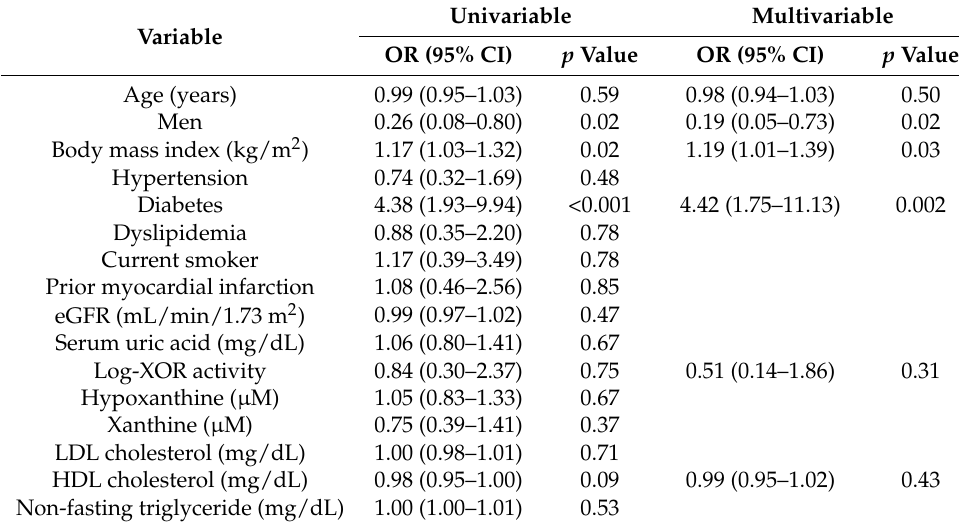
Table 2. Factors associated with an endothelial dysfunction (RHI < 1.67).